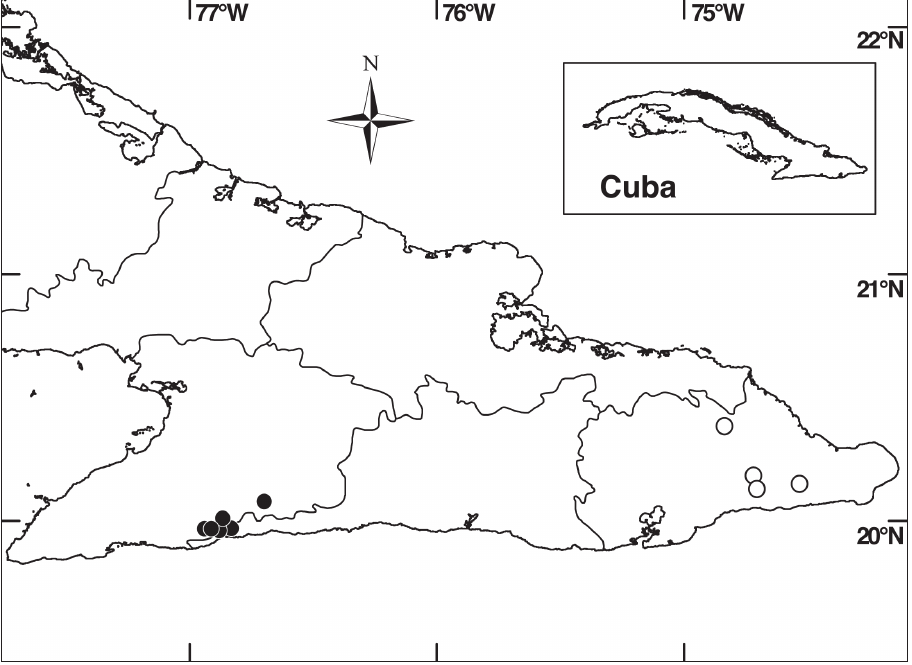
Figure 2. Distribution of M. hirtistyla in Granma and Santiago de Cuba provinces (closed circles) and M. bullotricha in Guantánamo Province (open